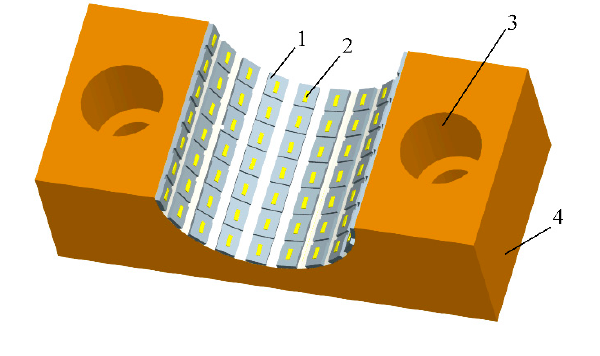
Figure 6. A three-dimensional (3D) view of the LD module (10 × 20 × 15 mm).